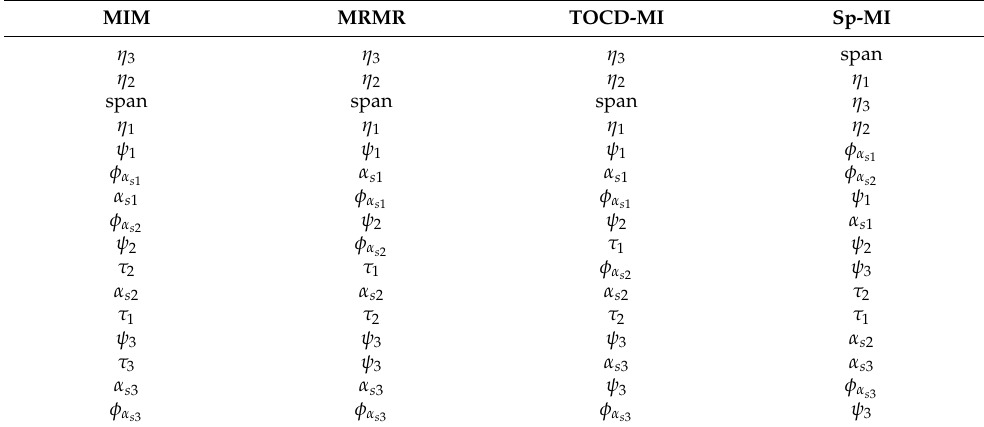
Table 1. Parameter ranking result of Flevoland image based on different methods of mutual information.